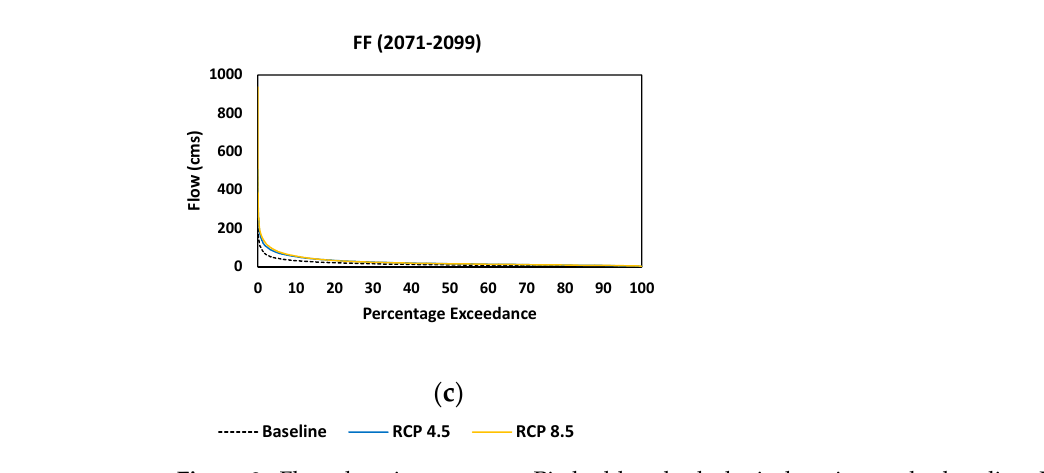
Figure 9. Flow duration curves at Pitabeddara hydrological station under baseline, RCP4.5 and RCP8.5 in ( a ) NF, ( b ) MF and ( c ) FF periods.